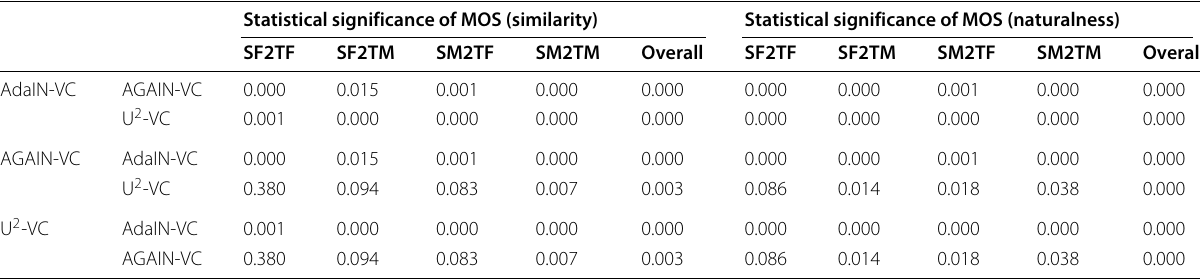
Table 10 Statistical significance of the MOS results of mono-lingual conversion in seen-to-seen scenario Statistical significance of MOS (similarity)